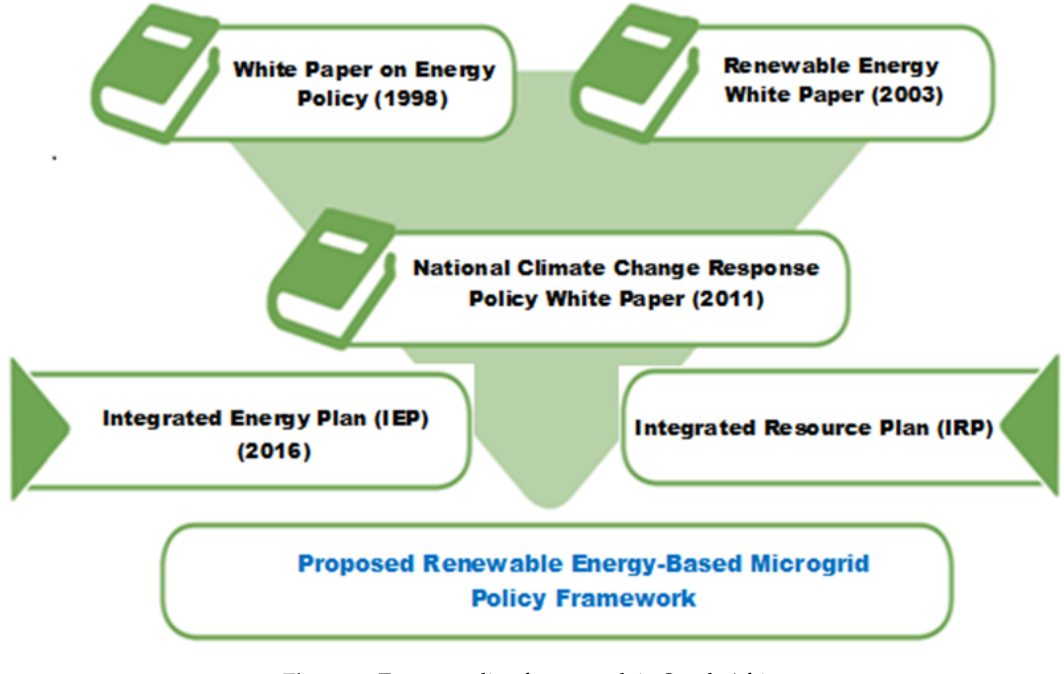
Figure 7. Energy policy framework in South